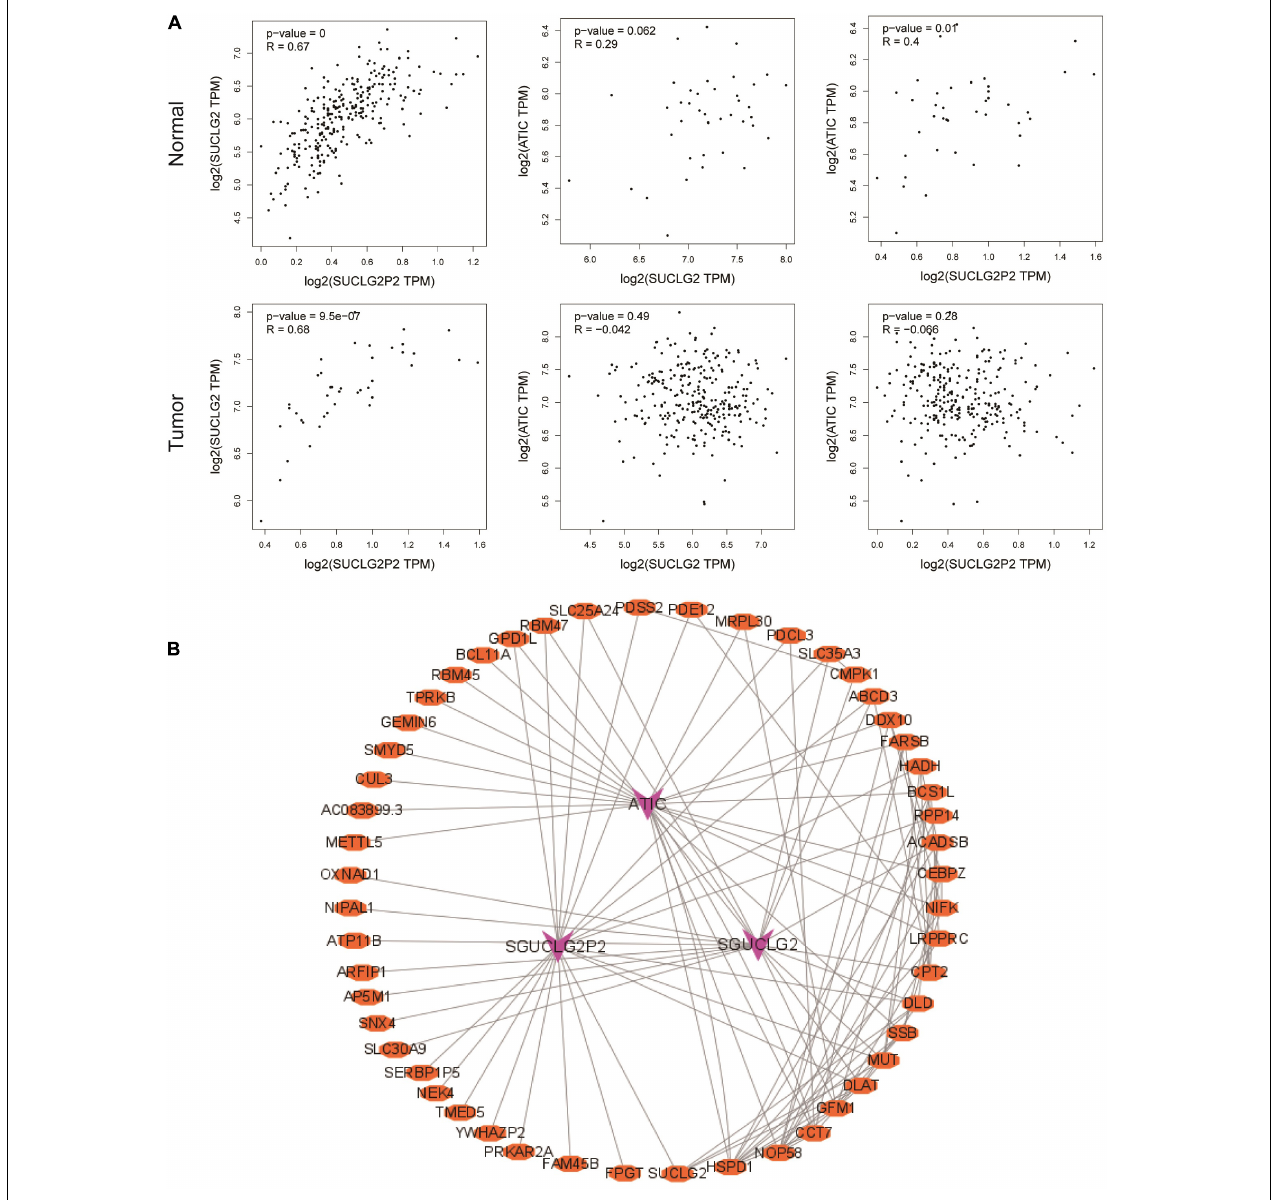
FIGURE 5 | Correlation and co-expression analysis of SUCLG2P2, SUCLG2 and ATIC genes. (A) Pearman analysis of the correlation between SUCLG2P2, SUCLG2 and ATIC in normal tissue and tumor tissue from GEPIA database. (B) The co-expression network of three genes was constructed by Cytoscape software.